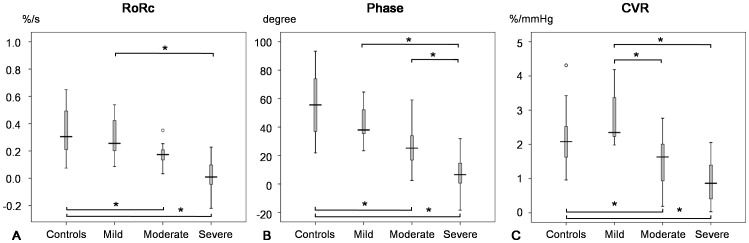
Box plots of cerebral autoregulation and cerebrovascular reactivity (CVR).The figures in rows are the rate of recovery (RoRc) (A), phase (B), and CVR (C) according to the degree of middle cerebral artery (MCA) stenosis. * denotes p<0.05 between the groups. ○ denotes exceeding values (>1.5 box length).